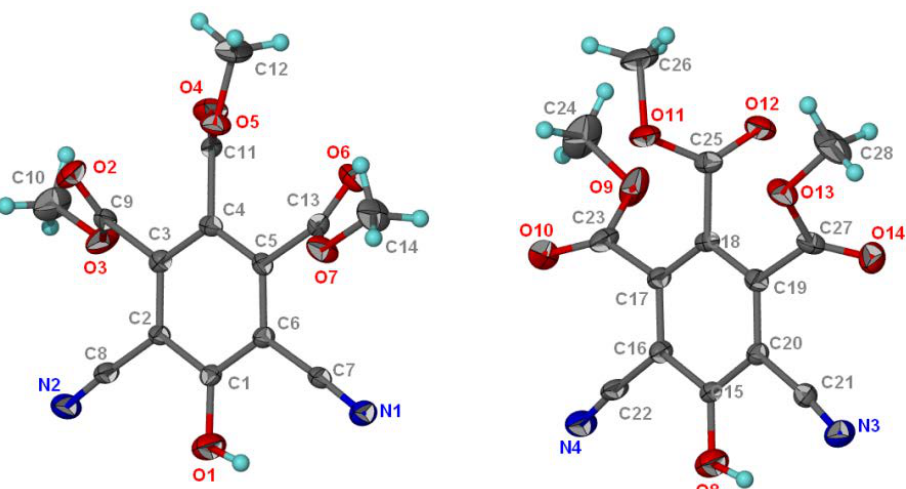
Figure 1. X-Ray crystal structure of 2